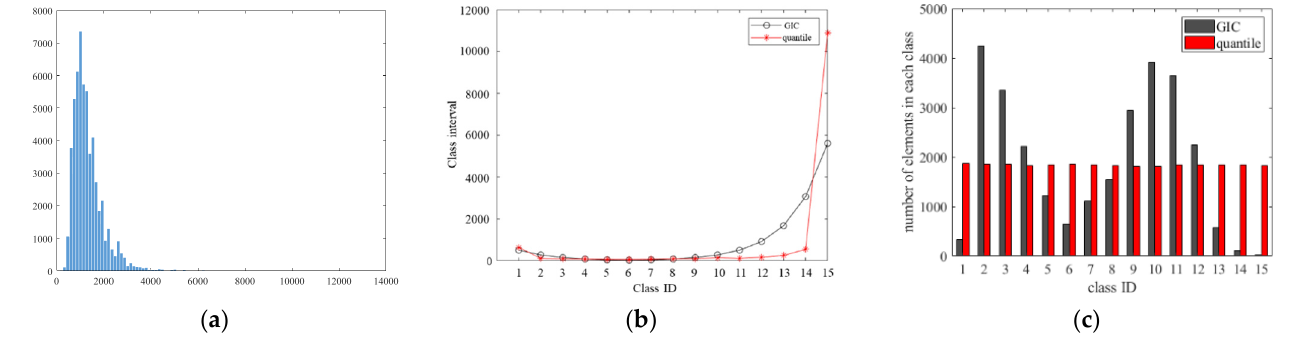
Figure 3. Histogram of Indiana population ( a ), class intervals ( b ), and number of samples ( c ) for each class determined by the quantile and GIC methods.